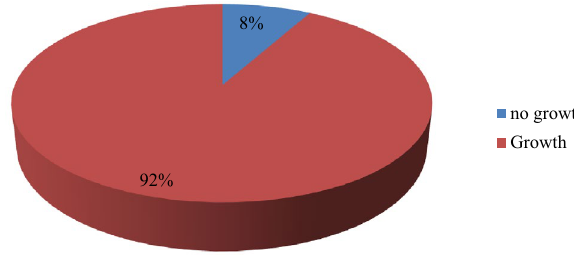
Figure 1. Overall prevalence of chronic wound infection isolates. This figure shows the overall prevalence of isolates in chronic wound infection. 75 wound swabs were inoculated on routine laboratory culture media for growth and pathogens were identified based on morphological, cultural characteristics and biochemical tests. Overall, 69 (92%) isolates were identified from 75 samples while 6 (8%) samples exhibited no growth.